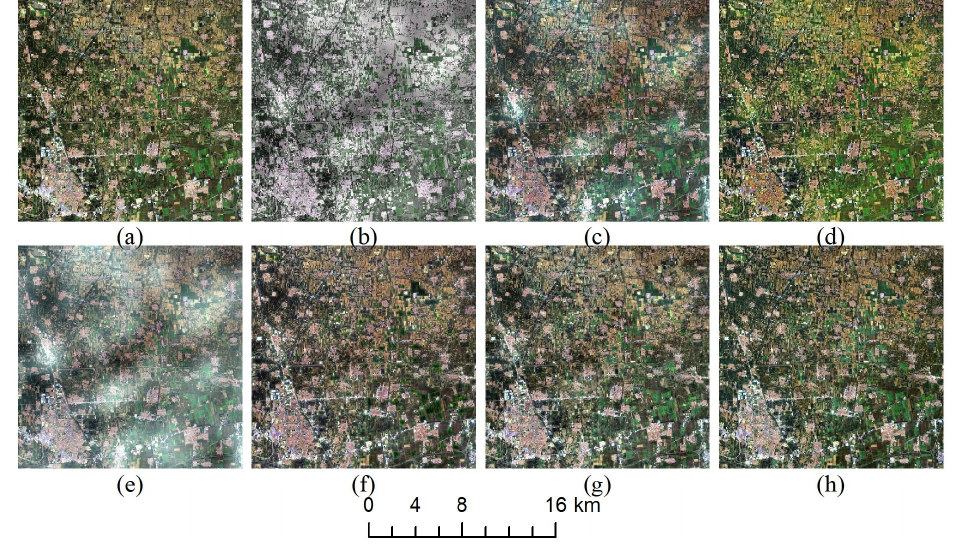
Figure 9. Dehazing results of different methods on simulated images: ( a ) original clear image; ( b ) HOT [5]; ( c ) DCP [15]; ( d ) HTM [11]; ( e ) simulated hazy image; ( f ) DehazeNet [30]; ( g ) VGGNet